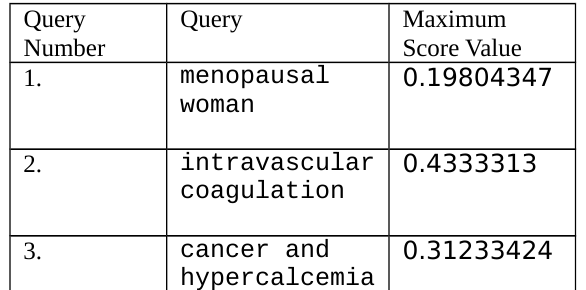
Figure 7 . Output Screenshot: Score values of the retrieved documents